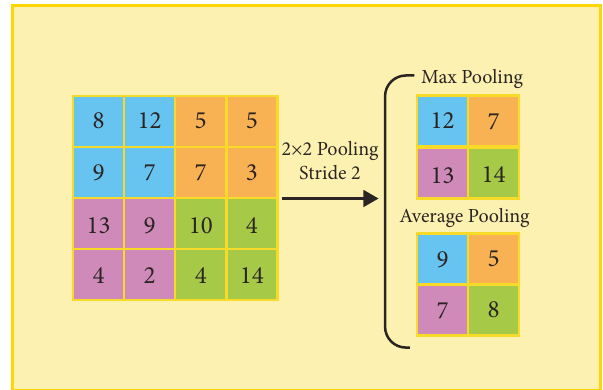
Figure 12: Pooling layer